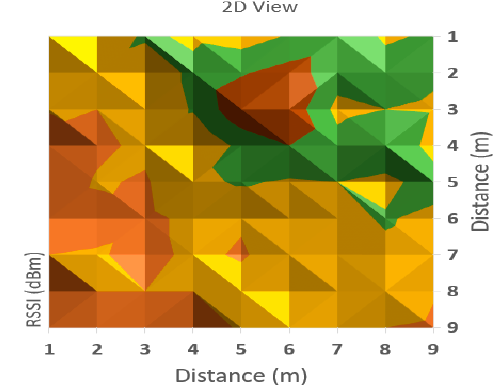
Figure 9. A three-dimensional representation of signal variation with different coloring according to RSSI measured values (Measurement point: MeS 2 ).